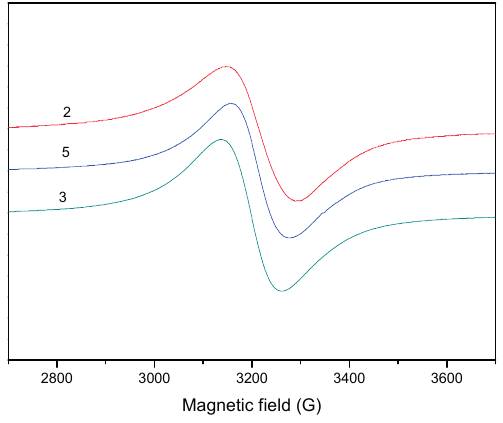
Figure 10. EPR spectra for the complexes 2 , 3 and 5 in powder, at room temperature.